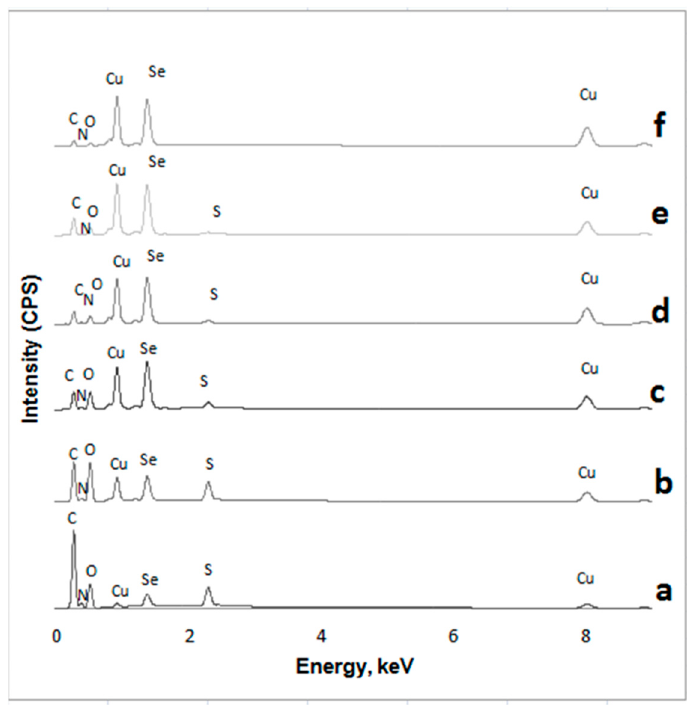
Figure 7. EDX spectra of treated wool samples after different numbers of cycles: a—1, b—2, c—3, d—4, e—5 and f—6. Table 4. Surface elemental composition of the investigated treated wool